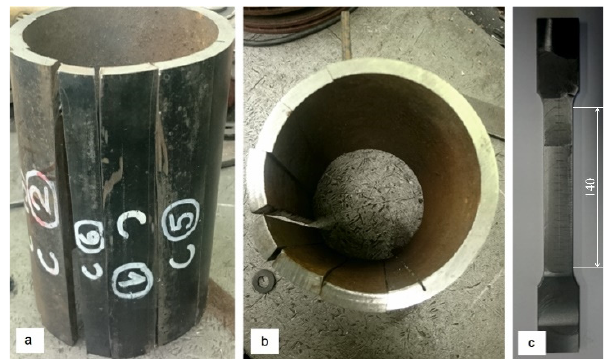
Figure 22. The blanks for specimens: ( a ) number of blanks; ( b ) orientations of blanks ( c ) specimen. To identify the cross sections area of the specimens (Table 1), the cross sections pa- rameters such as length a and thickness b were measured. The Young’s modulus E = 204 GPa, yield stress 𝜎 (cid:3052) = 581 MPa and ultimate stress 𝜎 (cid:3048) = 663 MPa (Table 1) were ob- tained as average from the experimental curves. Table 1. Mechanical characteristics of axle. Specimen